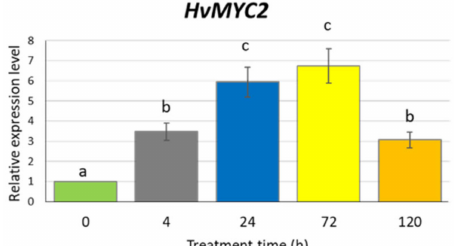
Figure 4. Expression of the HvMYC2 gene in the leaves of barley seedlings after 500 µ M methyl jasmonate treatment. The relative expression level was assessed to control plants grown without MeJA solution. The statistical analysis was performed using a one-way ANOVA followed by the Fisher Least Significant Di ff erence (LSD). Statistically significant di ff erences ( p < 0.05) are indicated by di ff erent